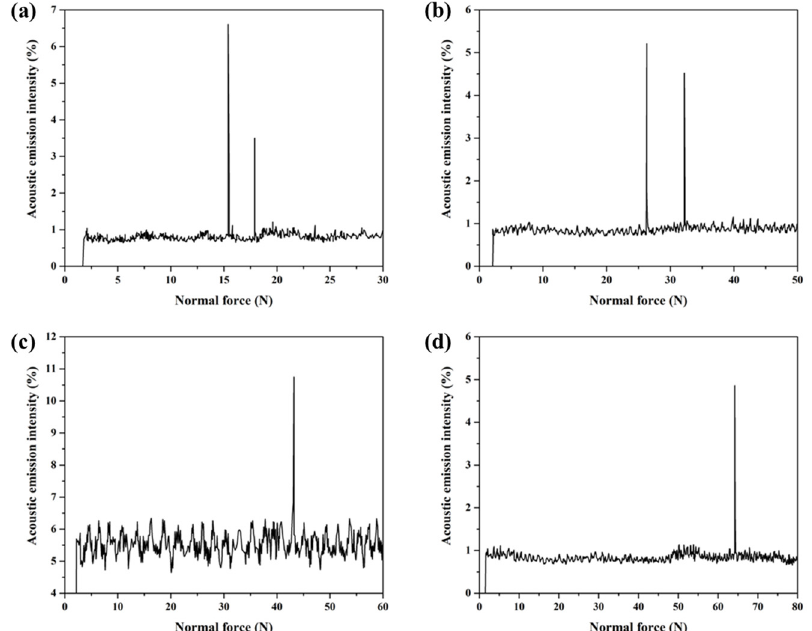
Figure 10. Acoustic emission spectra of the Cu35Ni25Co25Cr15 HEA coatings on the Cu substrate deposited under different welding currents: ( a ) 130 A; ( b ) 140 A; ( c ) 150 A; ( d ) 160 A.